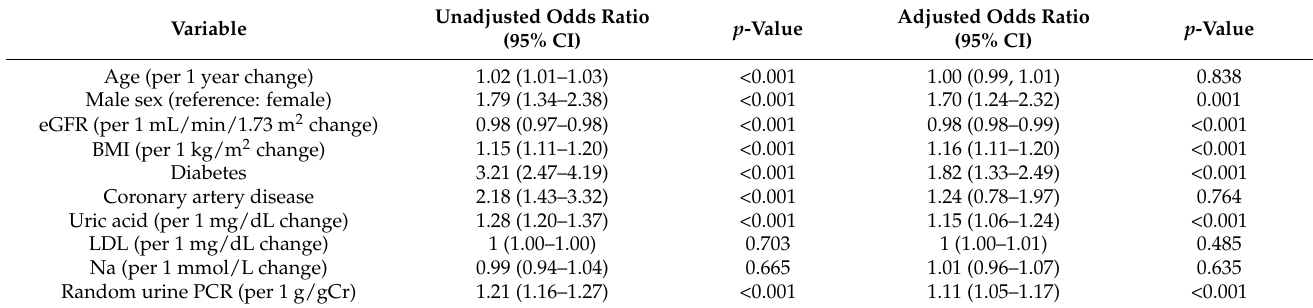
Table 2. Risk factors associated with